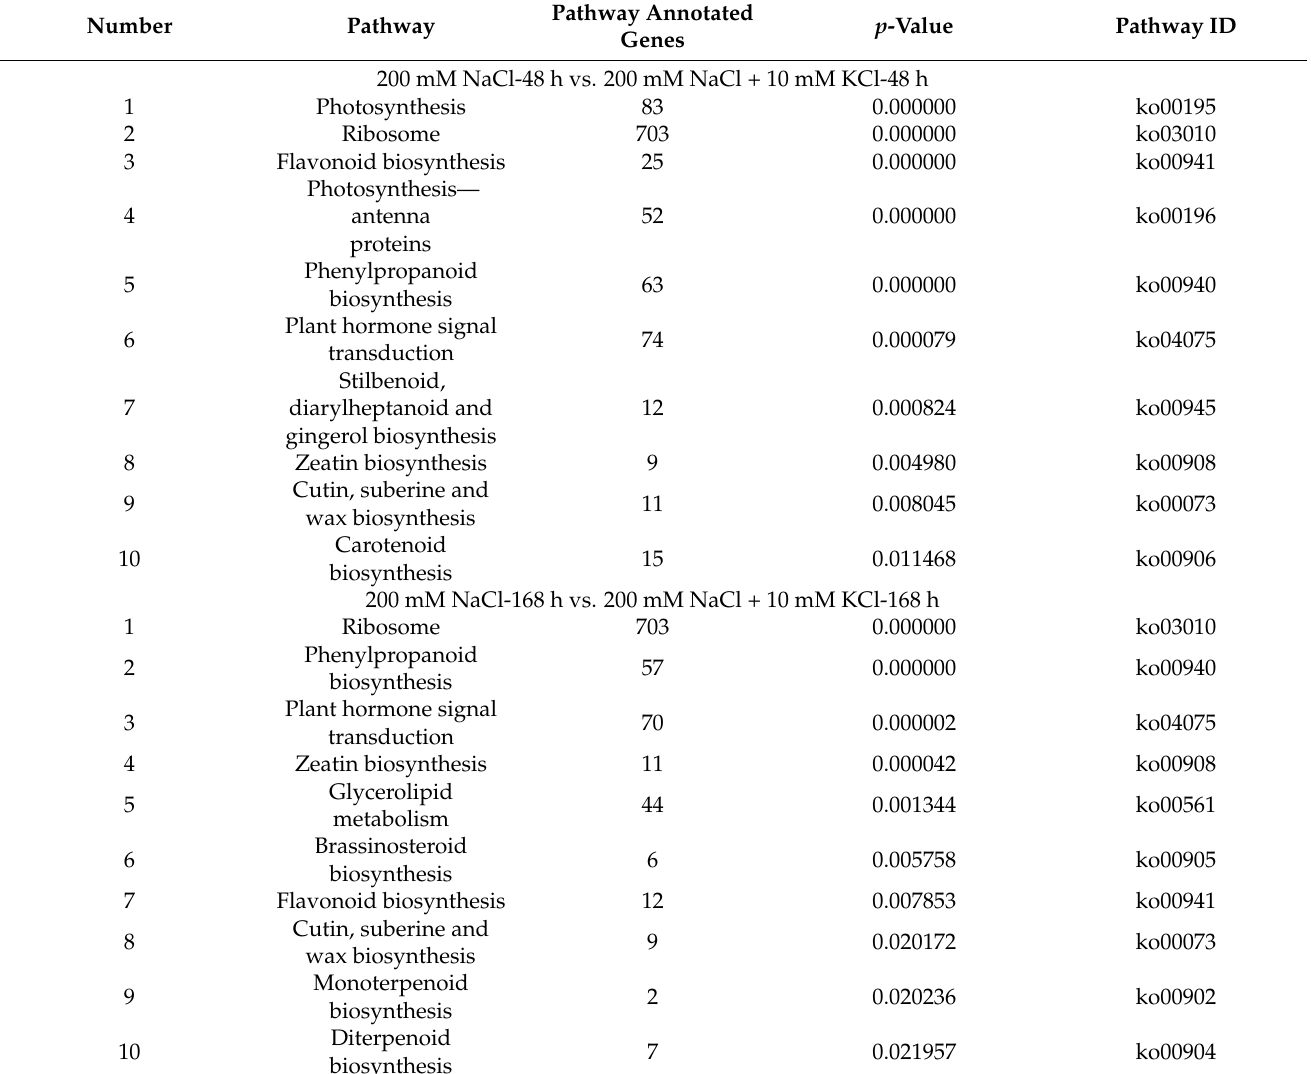
Table 1. Top 10 KEGG